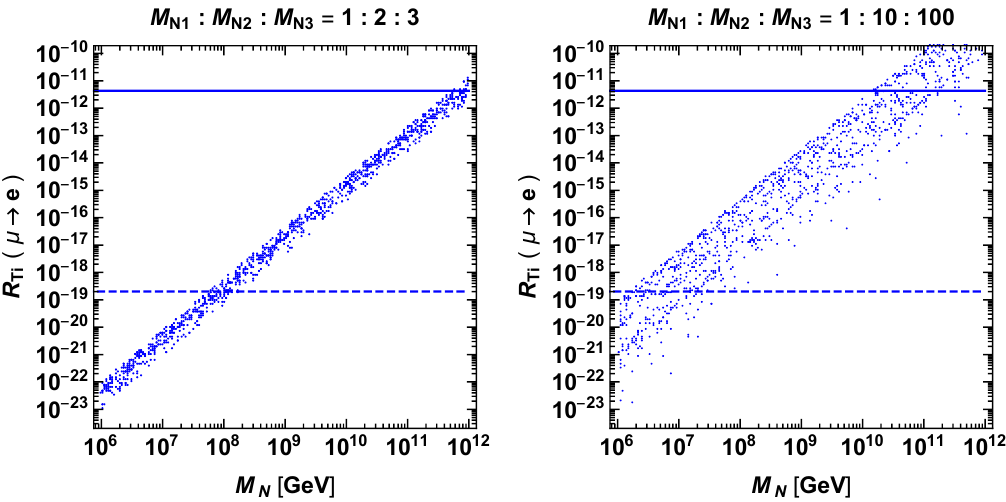
Figure 5 . R Ti ( µ → e ) is shown for the model A . The parameters are same as figure 3.